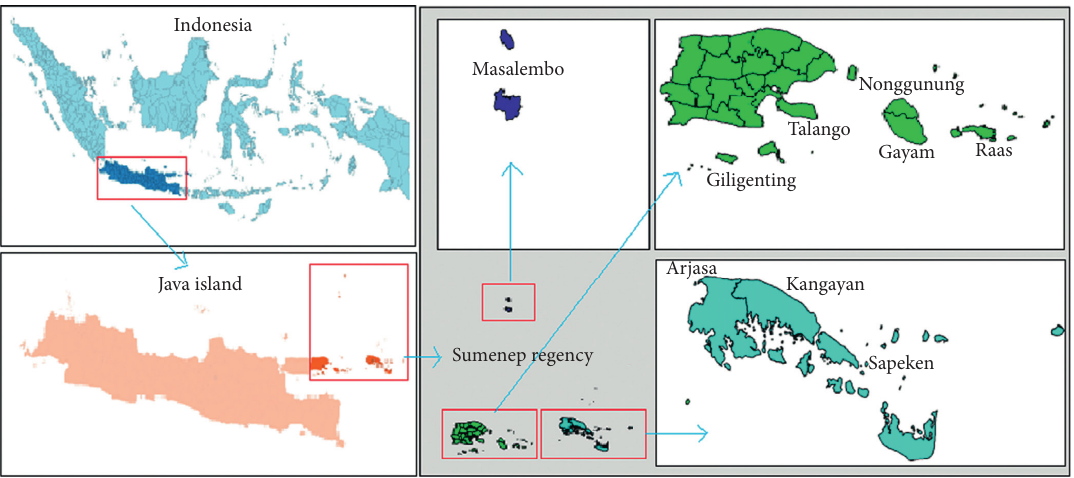
Figure 1: A map of the districts in Sumenep